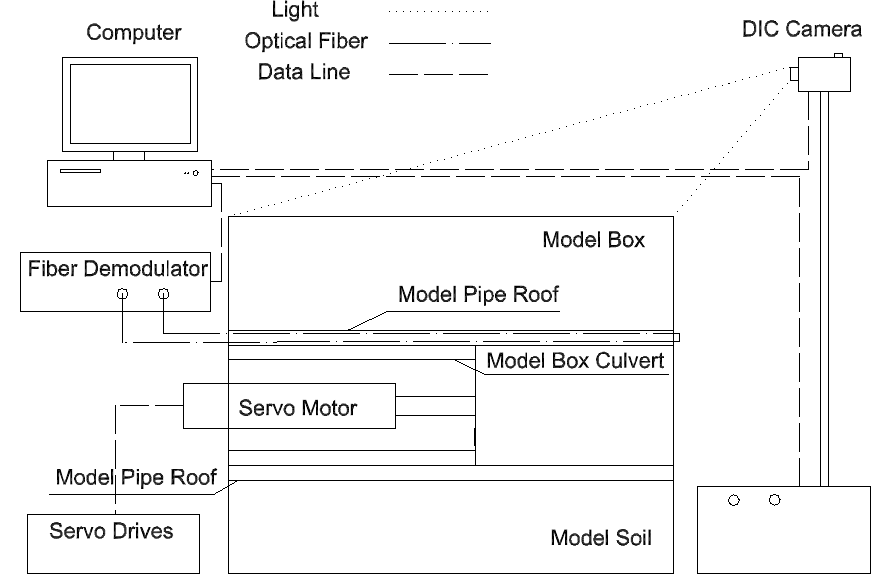
Figure 4. Box used in the laboratory